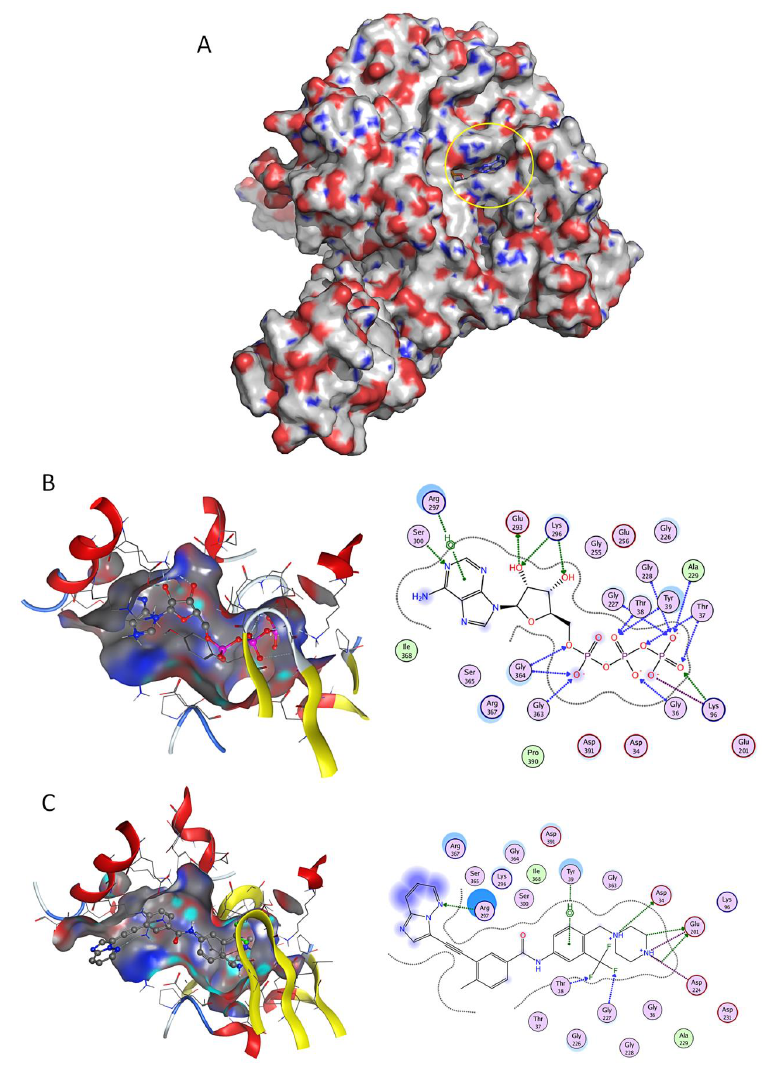
Figure 1. Docking studies on GRP78 nucleotide binding domain (NBD). ( A ) Three-dimensional (3D) surface structure of GRP78 (pdb code 5e84) showing its nucleotide-binding domains (yellow circle). ( B ) Crystallographic ATP, and ( C ) known drug Ponatinib, in 3D representation (left image) and respective two-dimensional (2D) interaction scheme (right image). The polar and non-polar amino-acids are shown in pink and green circles; hydrogen bonding is indicated by dotted arrows; with dotted lines represent arene-hydrogen interactions; proximity contour are dotted lines surrounding the ligand, indicating the shape of the binding site and available space to the more outward-facing parts of the ligand; blue shadows in some amino acids indicate the receptor exposure di ff erences by the size and intensity of the quoits disks. The directions of the shadows indicate the directions of the amino acids toward the ligands. The blue clouds around the ligand atoms indicate the solvent